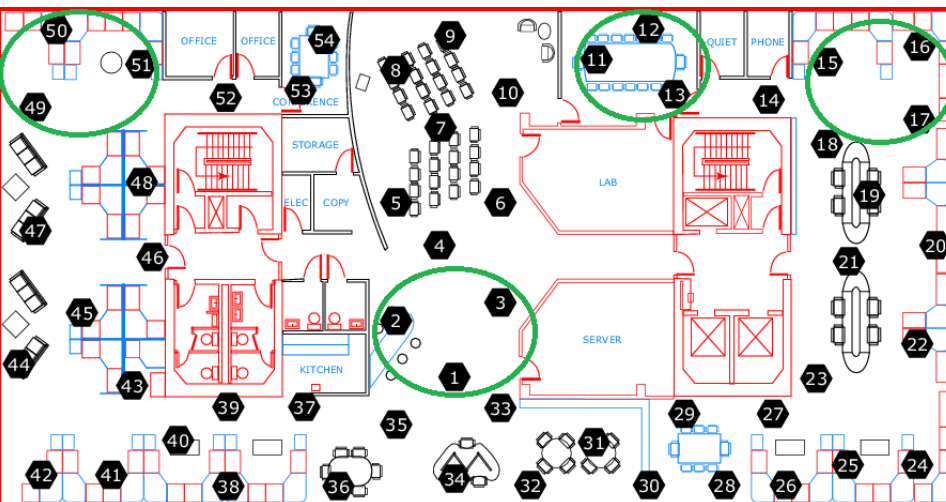
Figure 3. Intel Berkeley sensors arrangement diagram.